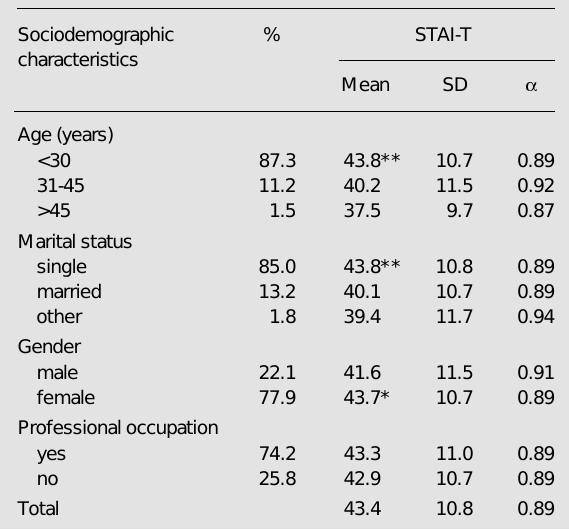
Table 1 - State-Trait Anxiety Inventory (trait form) (STAI-T) mean scores and standard deviation (SD) and a coefficients according to sociodemographic characteristics (N =